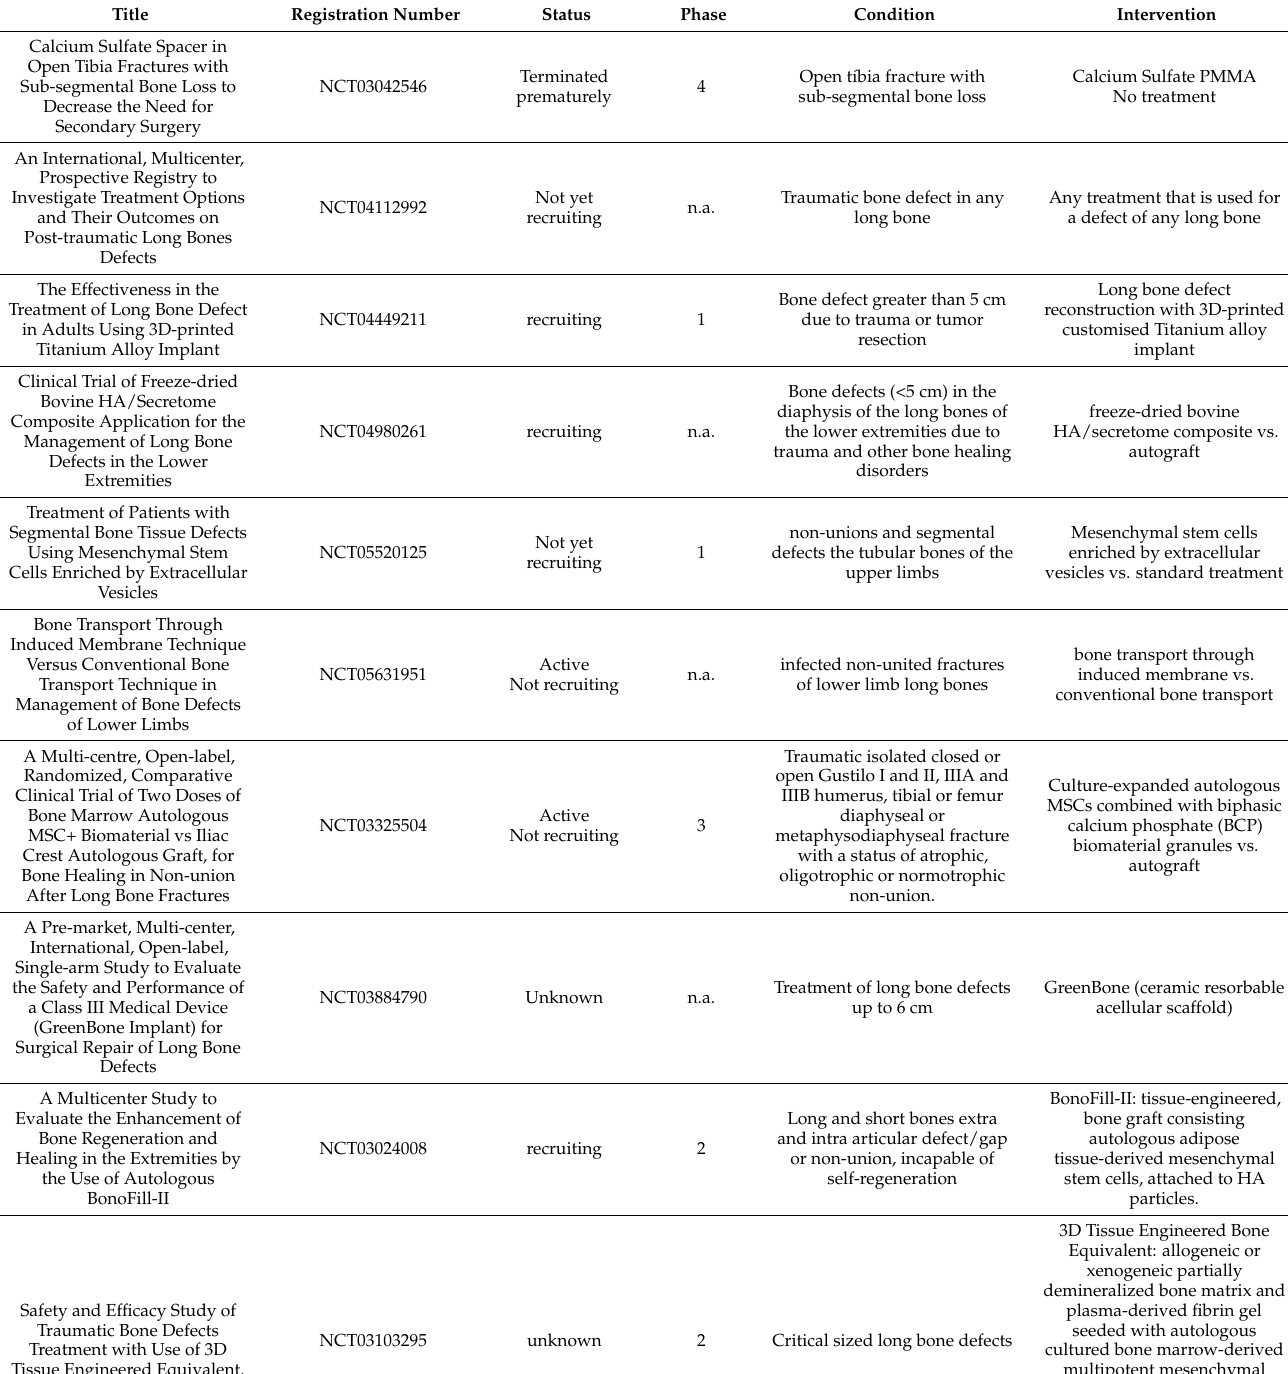
Table 2. Clinical trials investigating the reconstruction of long bone